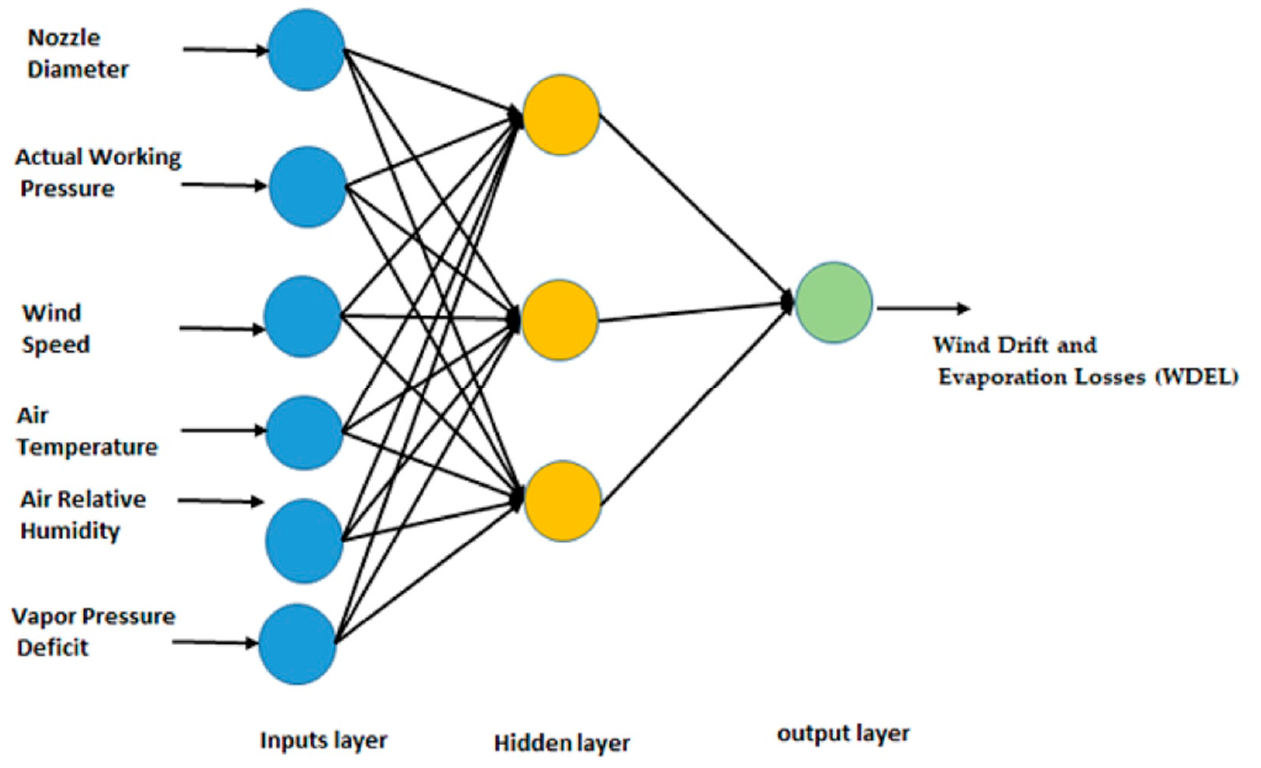
Figure 2. An ANN model with one hidden layer to predict WDEL. Each connection is linked with a weight. Sigmoid units are employed as hidden and output units (number of epochs were 500, error per epoch was 0.0072431, learning rate was 0.3, and momentum was 0.2). The hidden and output units are based on sigmoid units. Input is combined linearly by a sigmoid unit, which then applies the sigmoid function to the output. In Equation (5), the sigmoid transfer function for net input x is condensed.